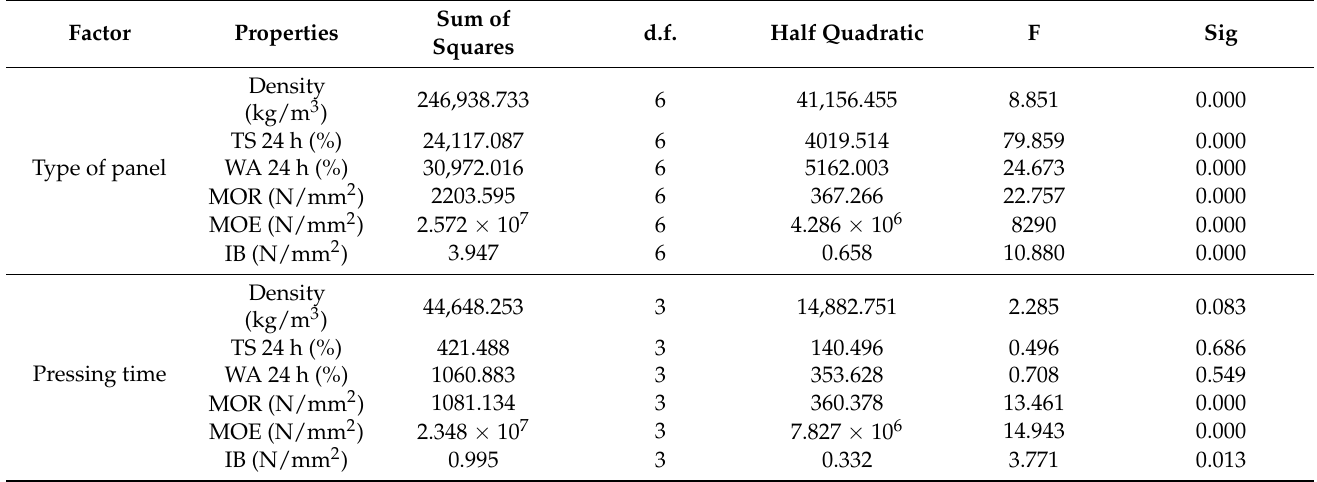
Table 4. ANOVA of the test results.